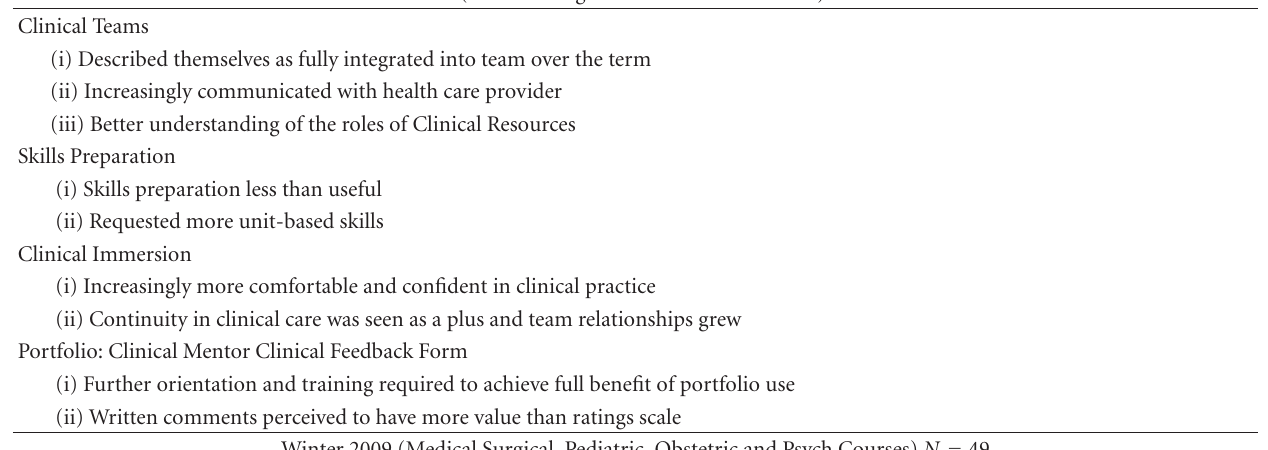
Table 4: Pilot student focus group